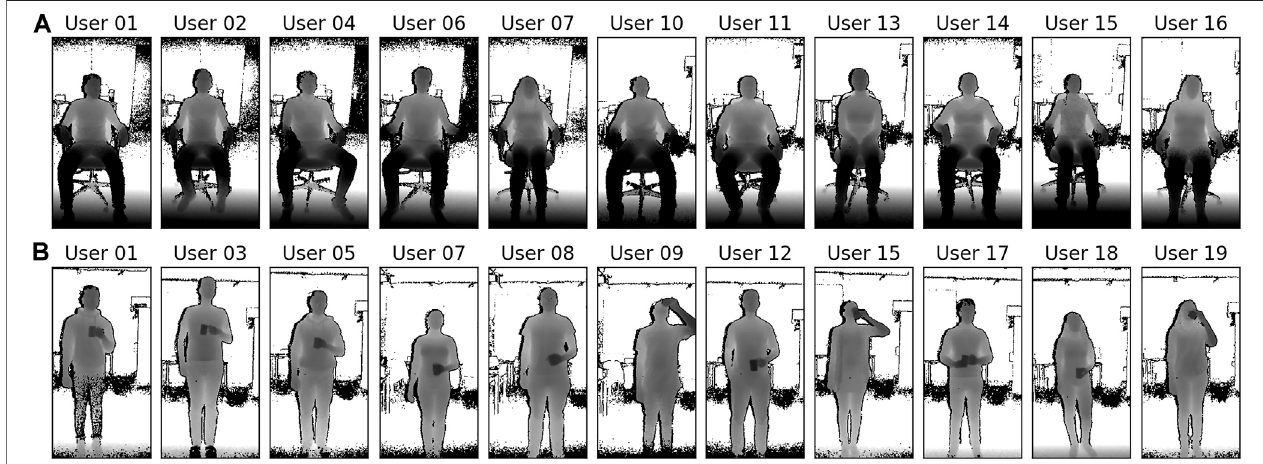
FIGURE 3 | In our study, 19 study participants (12 male, 7 female, all participants aged between 22 and 57 years old) were asked to sit or stand in front of a depth sensor and follow a breathing visualization. All participants were recorded for 20 sessions, each at 4 different distances from the depth camera, two different paced breathing rates, and for the three conditions sitting, standing, and standing with occlusion. Shown are exemplary depth data taken at a distance of 2 m from some participants while sitting (A) , and while holding a cup and performing drinking gestures (B) , leading to regular occlusions of the torso.